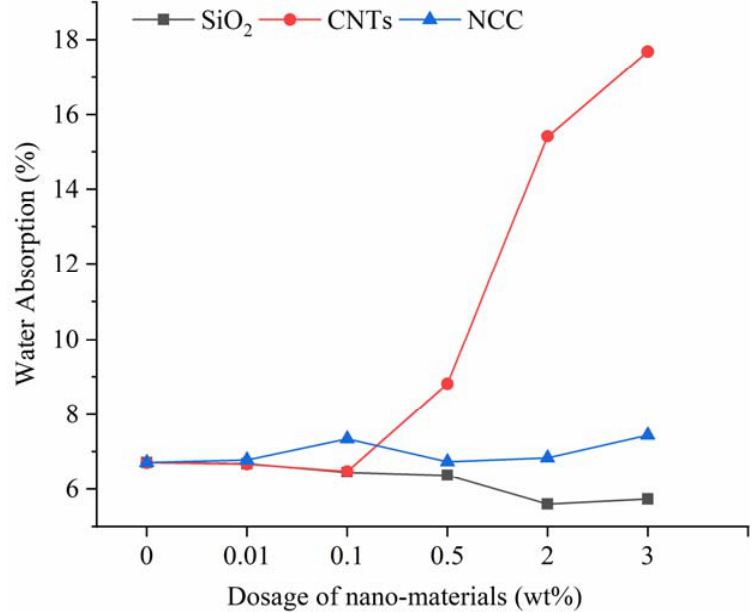
Figure 4. Effect of nanomaterial content on water absorption. Figure 4. E ff ect of nanomaterial content on water